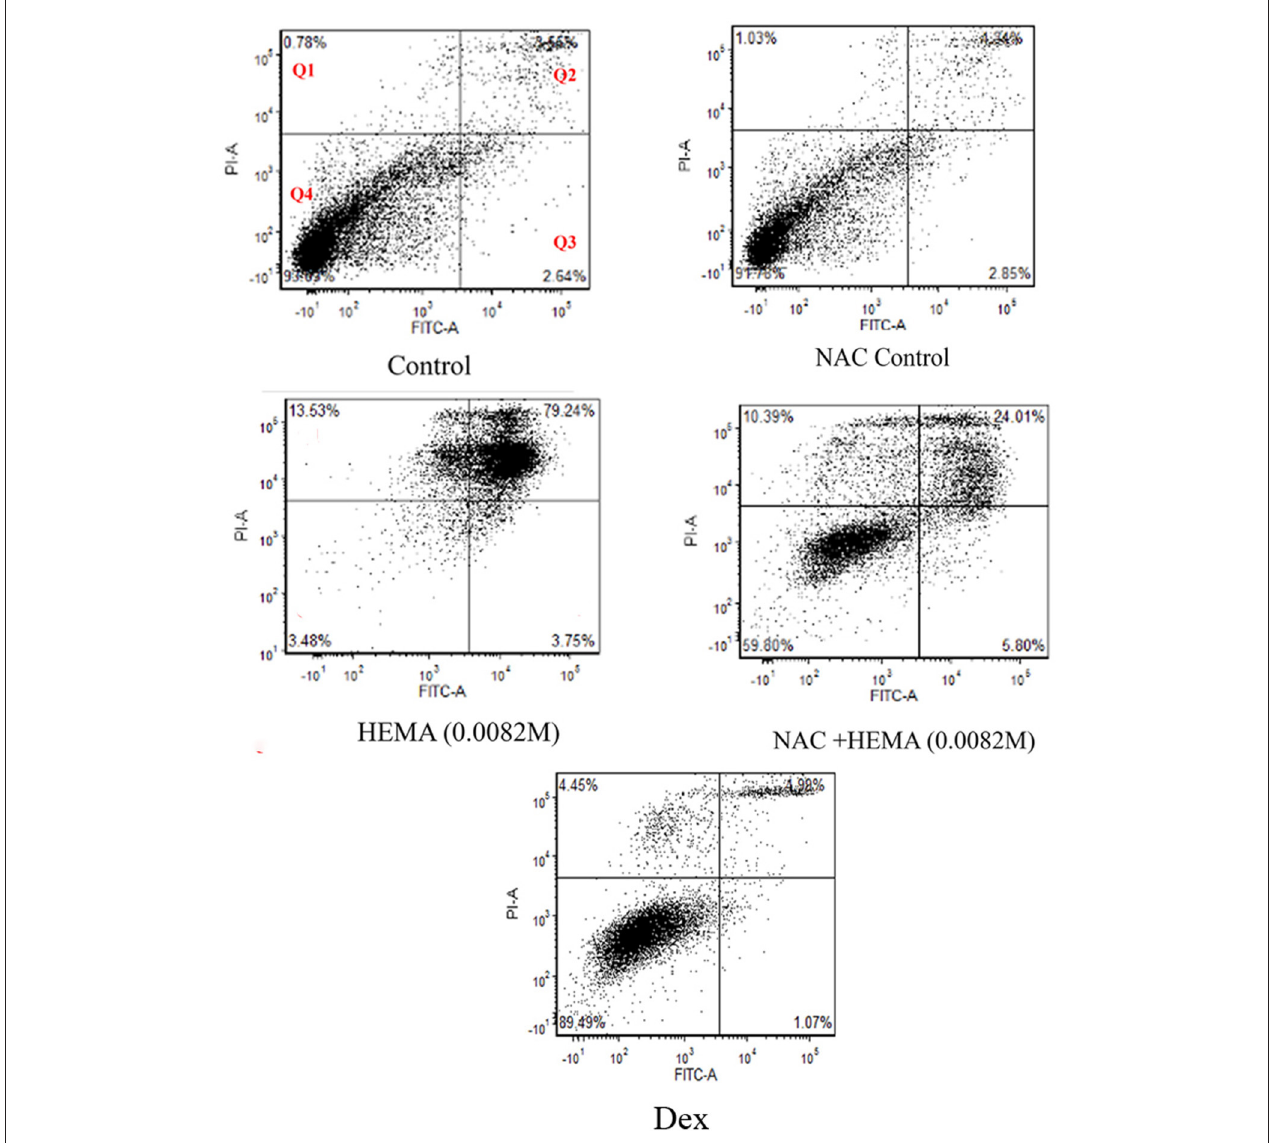
FIGURE 1 | Flow cytometric analysis demonstrated that NAC did not affect cell viability. Cell viability was analyzed after a 24-h treatment using FITC-Annexin V and Propidium Iodide (PI). Cells treated with HEMA showed the highest percentages of late apoptotic and necrotic cells as compared to those treated with NAC and HEMA. The NAC, Dex and the untreated control cells demonstrated similar percentages of viable cells (91.7%, 89.49%, and 93.6% respectively). 10,000 events were analyzed for each group. Q1 are the cells undergoing necrosis, Q2 are the cells in the stage of late apoptosis, Q3 are the cells in early apoptosis, and Q4 represents the viable